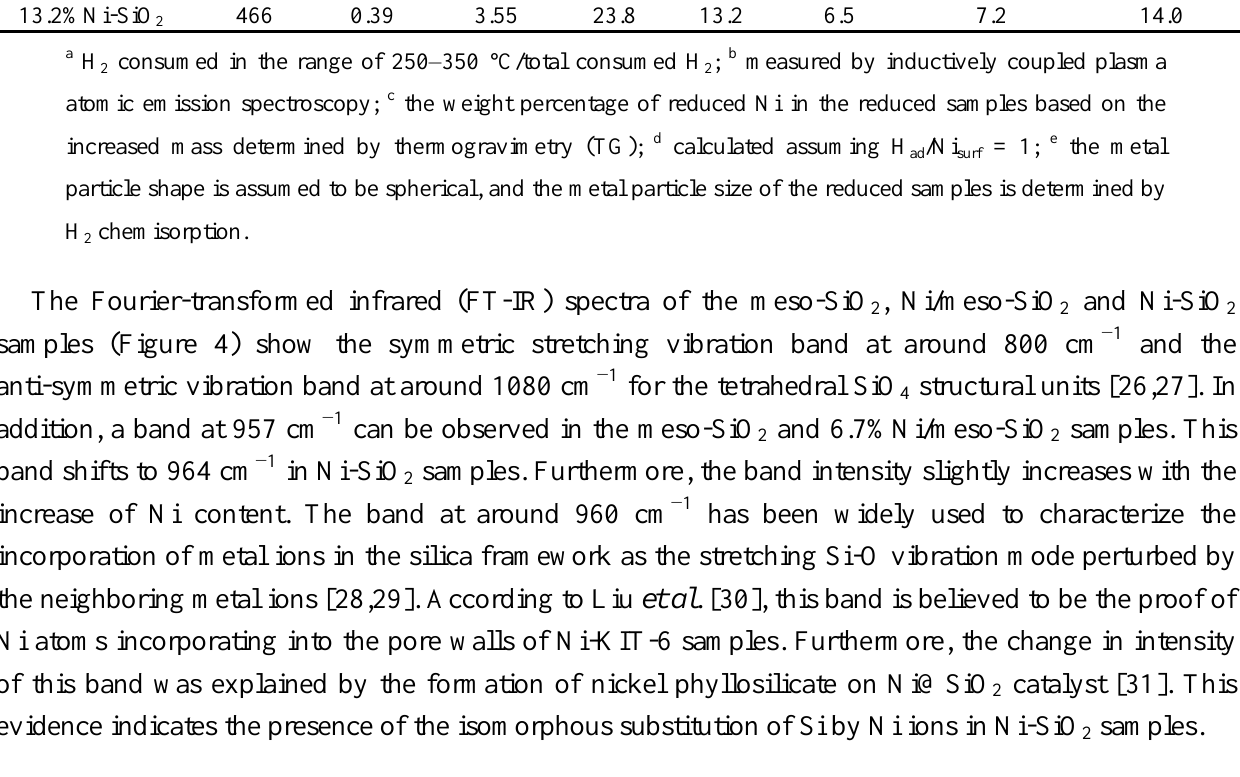
Figure 4. FT-IR spectra of the meso-SiO